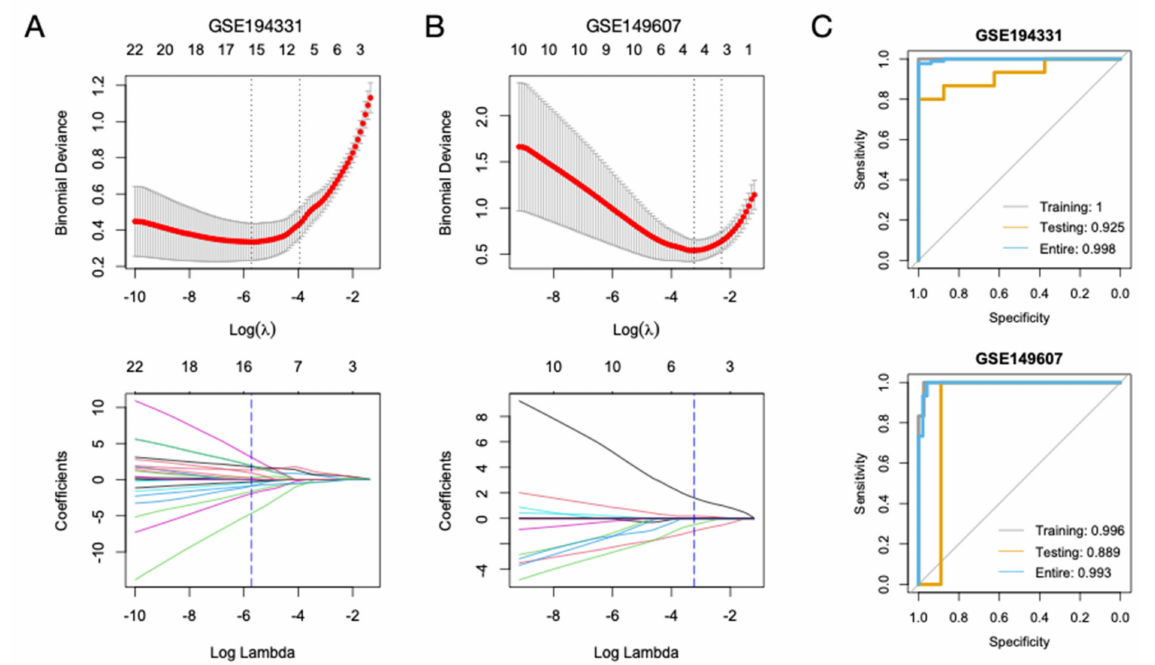
Figure 7. Construction of diagnostic models for AP. ( A , B ) Binomial deviance plot with lambda as the tuning parameter for GSE194331 and GSE149607 (upper panels). The red dots are the values of binomial deviance. The gray lines indicate the standard error (SE). The vertical dashed lines indicate the optimal values by the minimum criteria and 1-SE criteria. The least absolute shrinkage and selection operator (LASSO) coefficient profile of the selected genes is shown in the lower